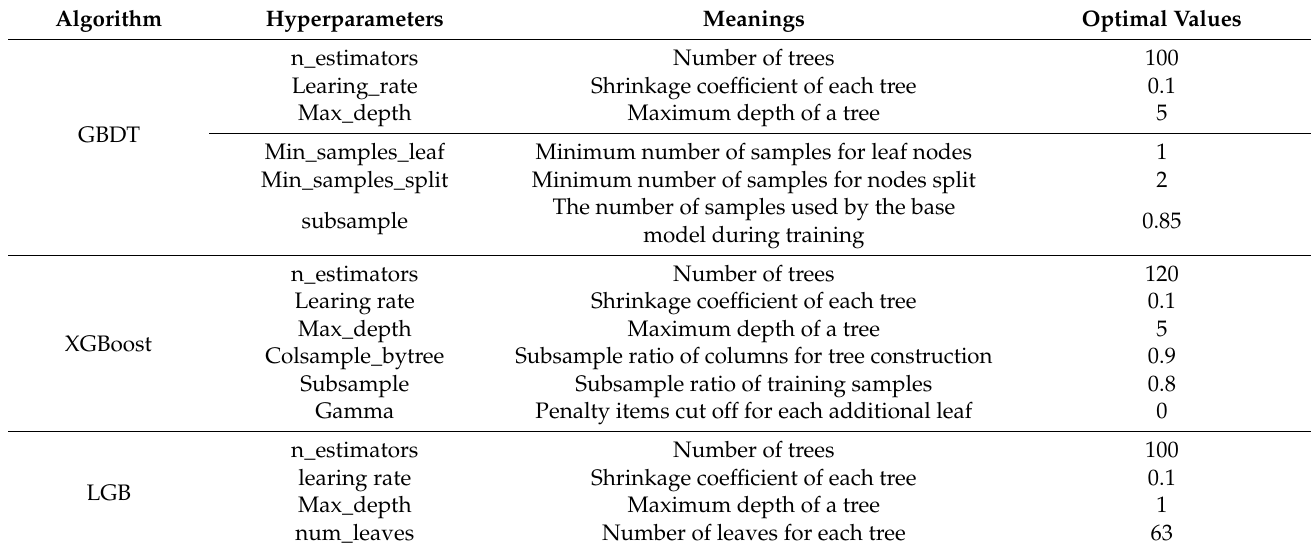
Table 2. Summary of Hyperparameters of Each Basic